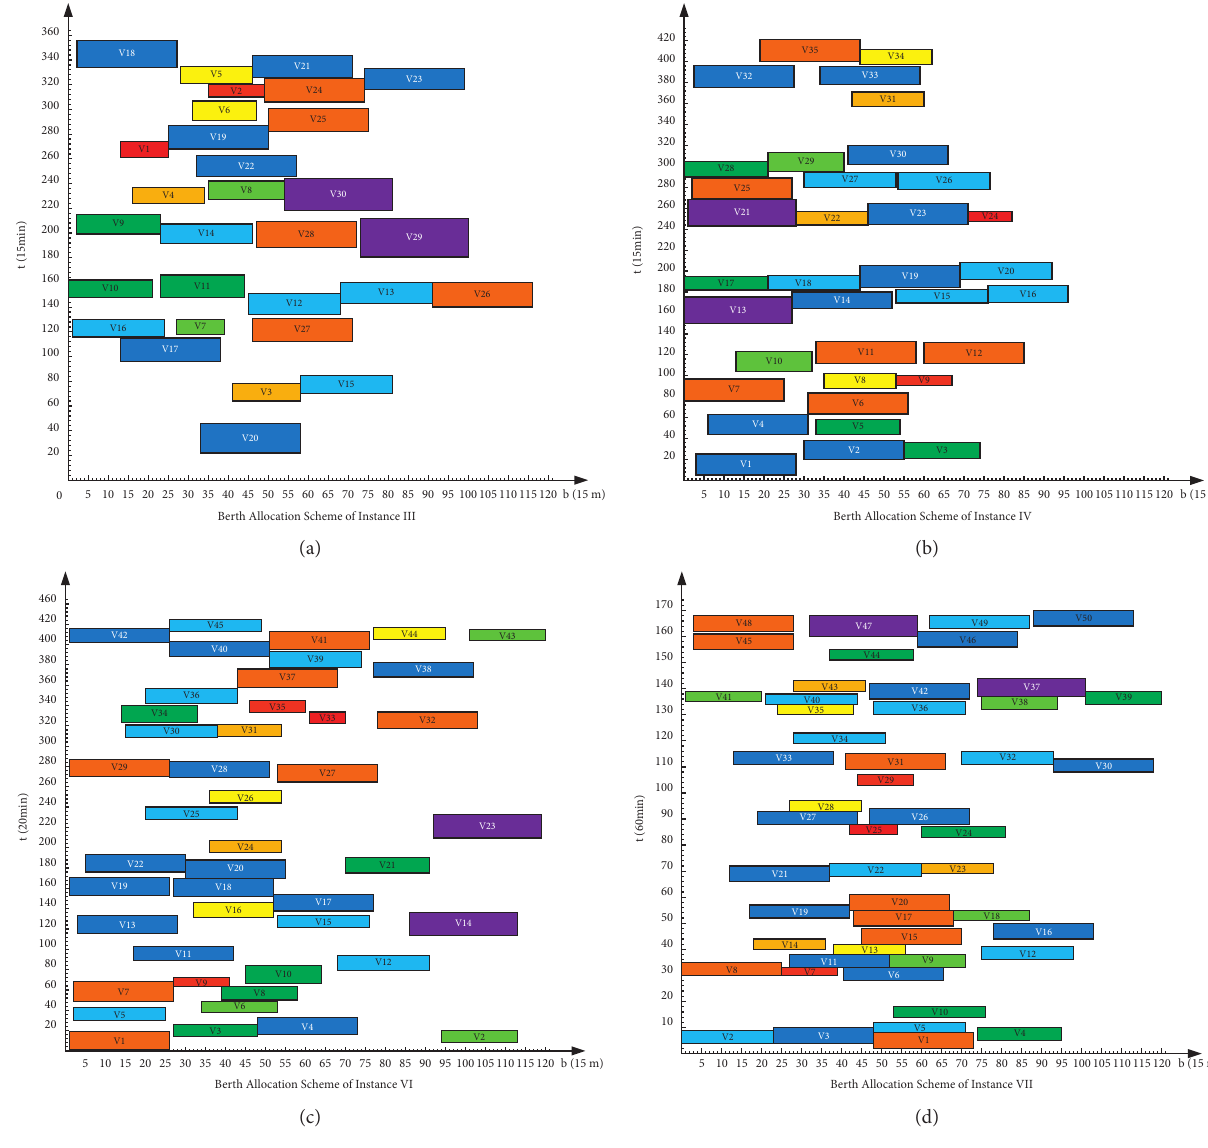
Figure 6: The berth allocation scheme about part of instances. (a) Berth allocation scheme of instance III. (b) Berth allocation scheme of instance IV. (c) Berth allocation scheme of instance VI. (d) Berth allocation scheme of instance